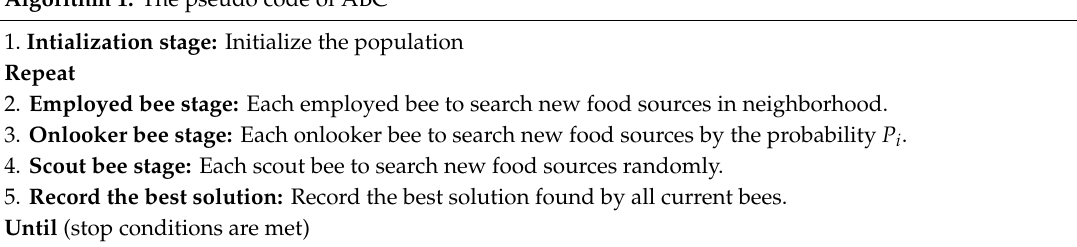
Algorithm 1. The pseudo code of